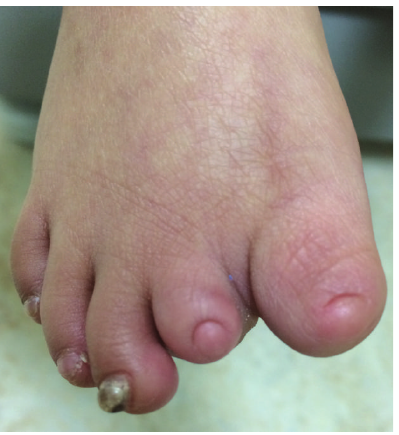
Figure 3: Unilateral terminal reduction of the right first and second